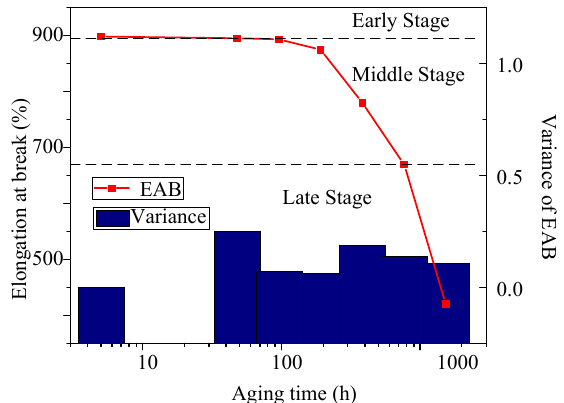
Figure 5. EABs and variance versus aging time. The FTIR spectra of cable insulation versus aging time are shown in Figure 6. At the early aging stage (thermal aging 48–96 h), no significant change in the FTIR spectra of XLPE is observed except for the slight fluctuation in 1020–1380 cm − 1 . This feature could be explained by the fact that the antioxidant has not been consumed completely during this period. Additionally, the fluctuation of 1020–1380 cm − 1 band should be related to the consumption process of the antioxidants. These infrared absorption peaks appear at about 1078, 1159, and 1300 cm − 1 , respectively [4]. After 192 h of thermal aging, at the middle aging stage, the antioxidant is gradually exhausted; it can be seen that a new absorption peak appears at the wavenumber 1720 cm − 1 , and the intensity of this absorption peak increases with the increase in thermal aging time. This type of stretching vibration at 1720 cm − 1 corresponds to carbonyl (-C=O), showing that carbonyl is produced in crosslinked polyethylene during thermal aging; the carbonyl absorption peak can be used as the characteristic peak characterizing thermal oxygen aging. At the same time, it can also be seen from the spectrum that the intensity of the absorption band at the wavenumber 2750–3000 cm − 1 region and the intensity of the absorption peak at 720 cm − 1 and 1460 cm − 1 are significantly reduced, which is related to the increase in the carbonyl peak intensity and the emergence of the ether absorption peak at 1169 cm − 1 (the vibration frequency is 1000–1300 cm − 1 ). A large amount of carbonyl production leads to the reduction in the number of methyl groups (-CH, -CH 2 , and -CH 3 ). The carbonyl absorption peak increased drastically at wavenumber 1720 cm − 1 after thermally aged for 784 h (i.e., at the late aging stage), indicating that the cable has undergone chain breaking and oxidation reaction during this period [8]. The XRD spectra of XLPE insulation at different aging stages are shown in Figure